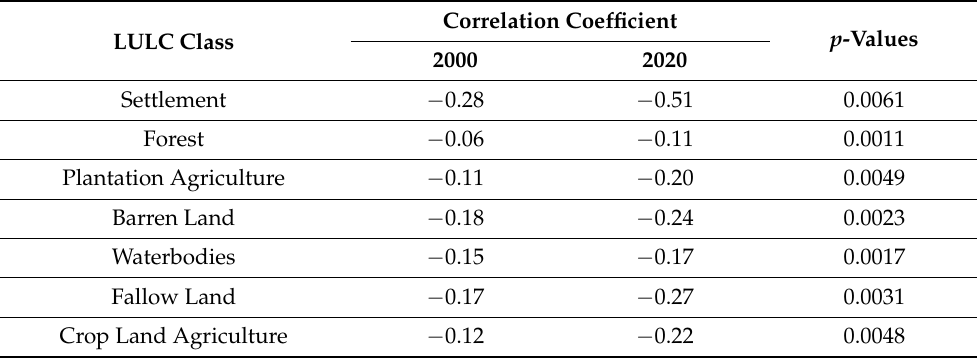
Table 9. Spearman correlation between Normalized Difference Vegetation Indices (NDVI), Soil- adjusted vegetation index (SAVI), and land surface temperature (LST) by landuse and landcover (LULC) zones. All correlation coefficients are statistically significant at p ≤